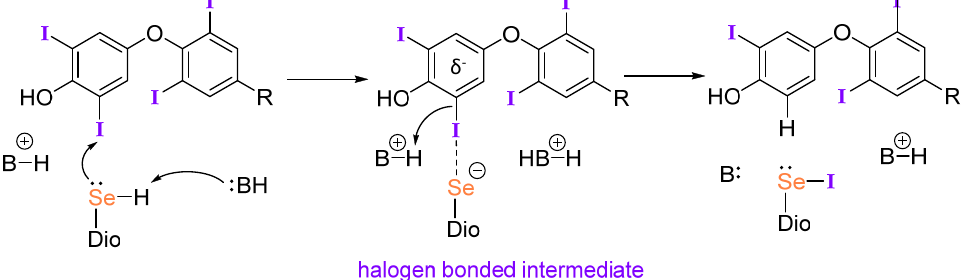
Figure 3. Proposed halogen bonding-based mechanism for deiodination by Dio adapted from reference [71]. The identities of B and their protonation states have not been determined.